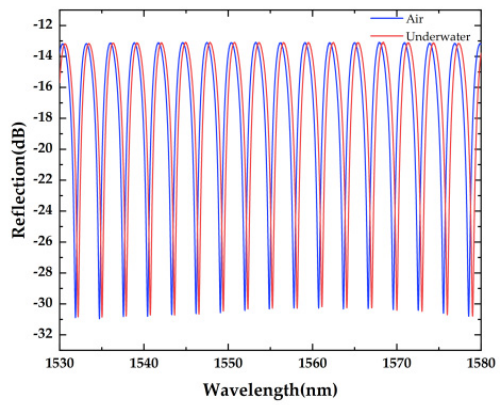
Figure 2. The reflection spectrum of the polymer cavity sensor.